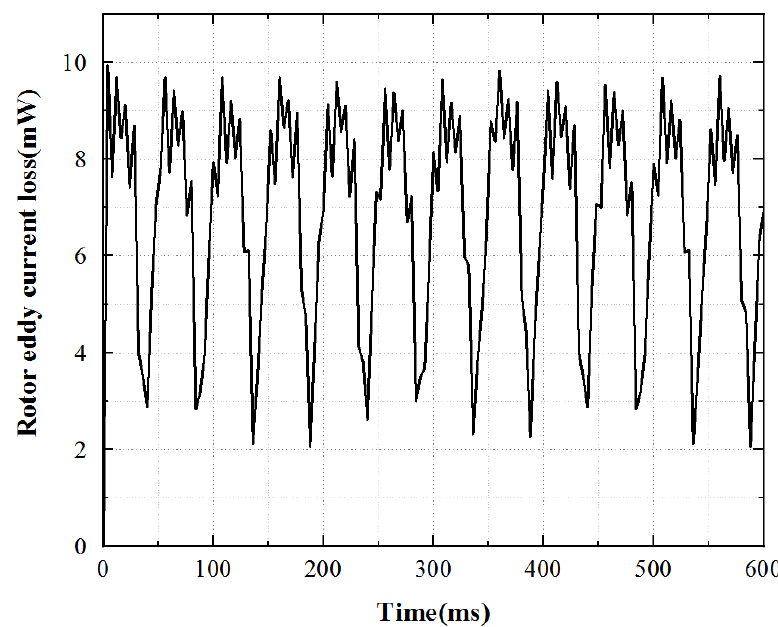
Figure 8. Rotor eddy current loss curve.